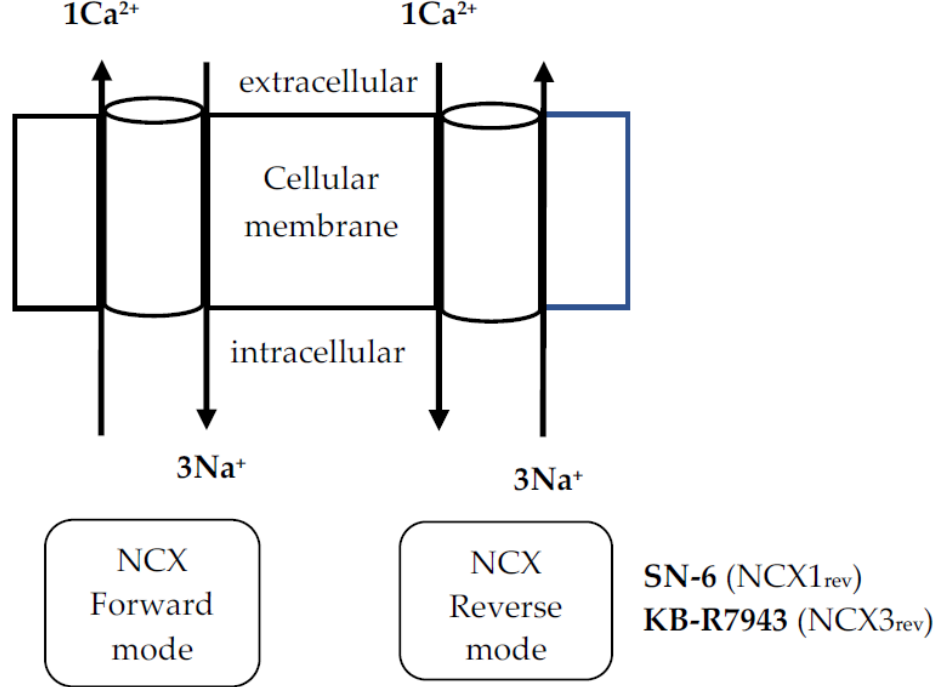
Figure 1. Schematic of Na + /Ca 2+ exchanger (NCX) function in cells. 2-[[4-[(4-nitrophenyl)methoxy]phenyl]methyl]-4-thiazoli dinecarboxylic acid ethyl ester) and KB-R7943 (2-[2-[4-(4-nitrobenzyloxy)phenyl]ethyl] isothioureamethanesulfonate) are potent inhibitors of reverse mode activity for NCX1 and NCX3 isoform, respectively.